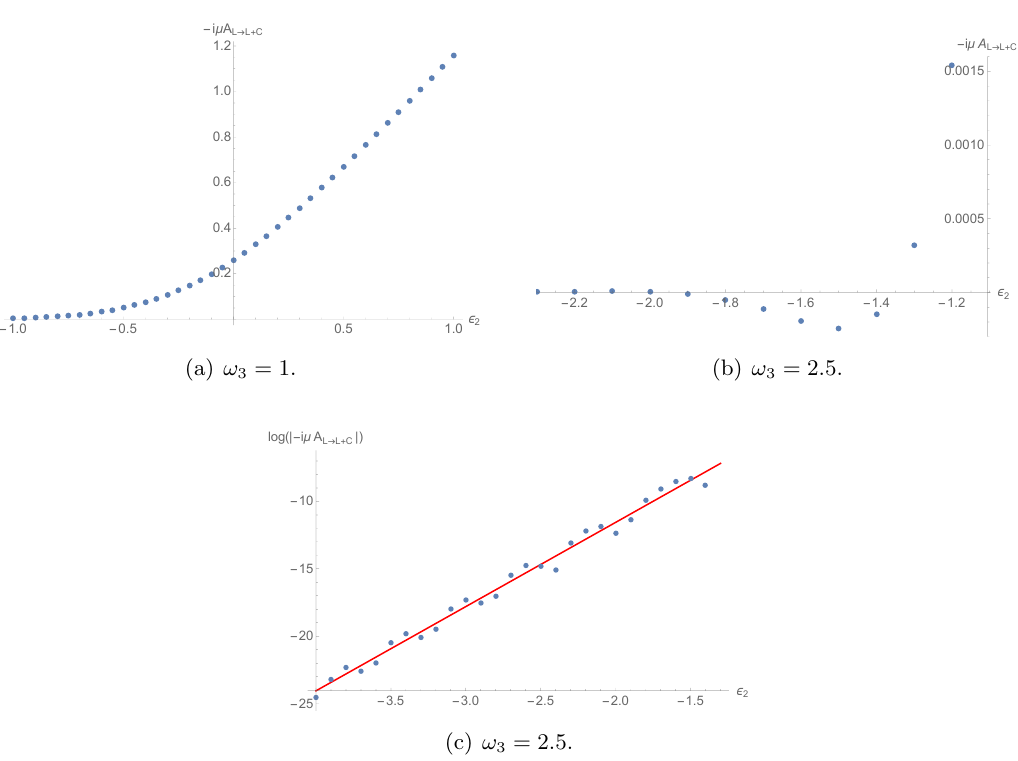
Figure 5 . Long string amplitude A L ! L + C evaluated at (cid:12)xed ! 3 as a function of (cid:15) 2 . Here we have rescaled the amplitude by (cid:22)